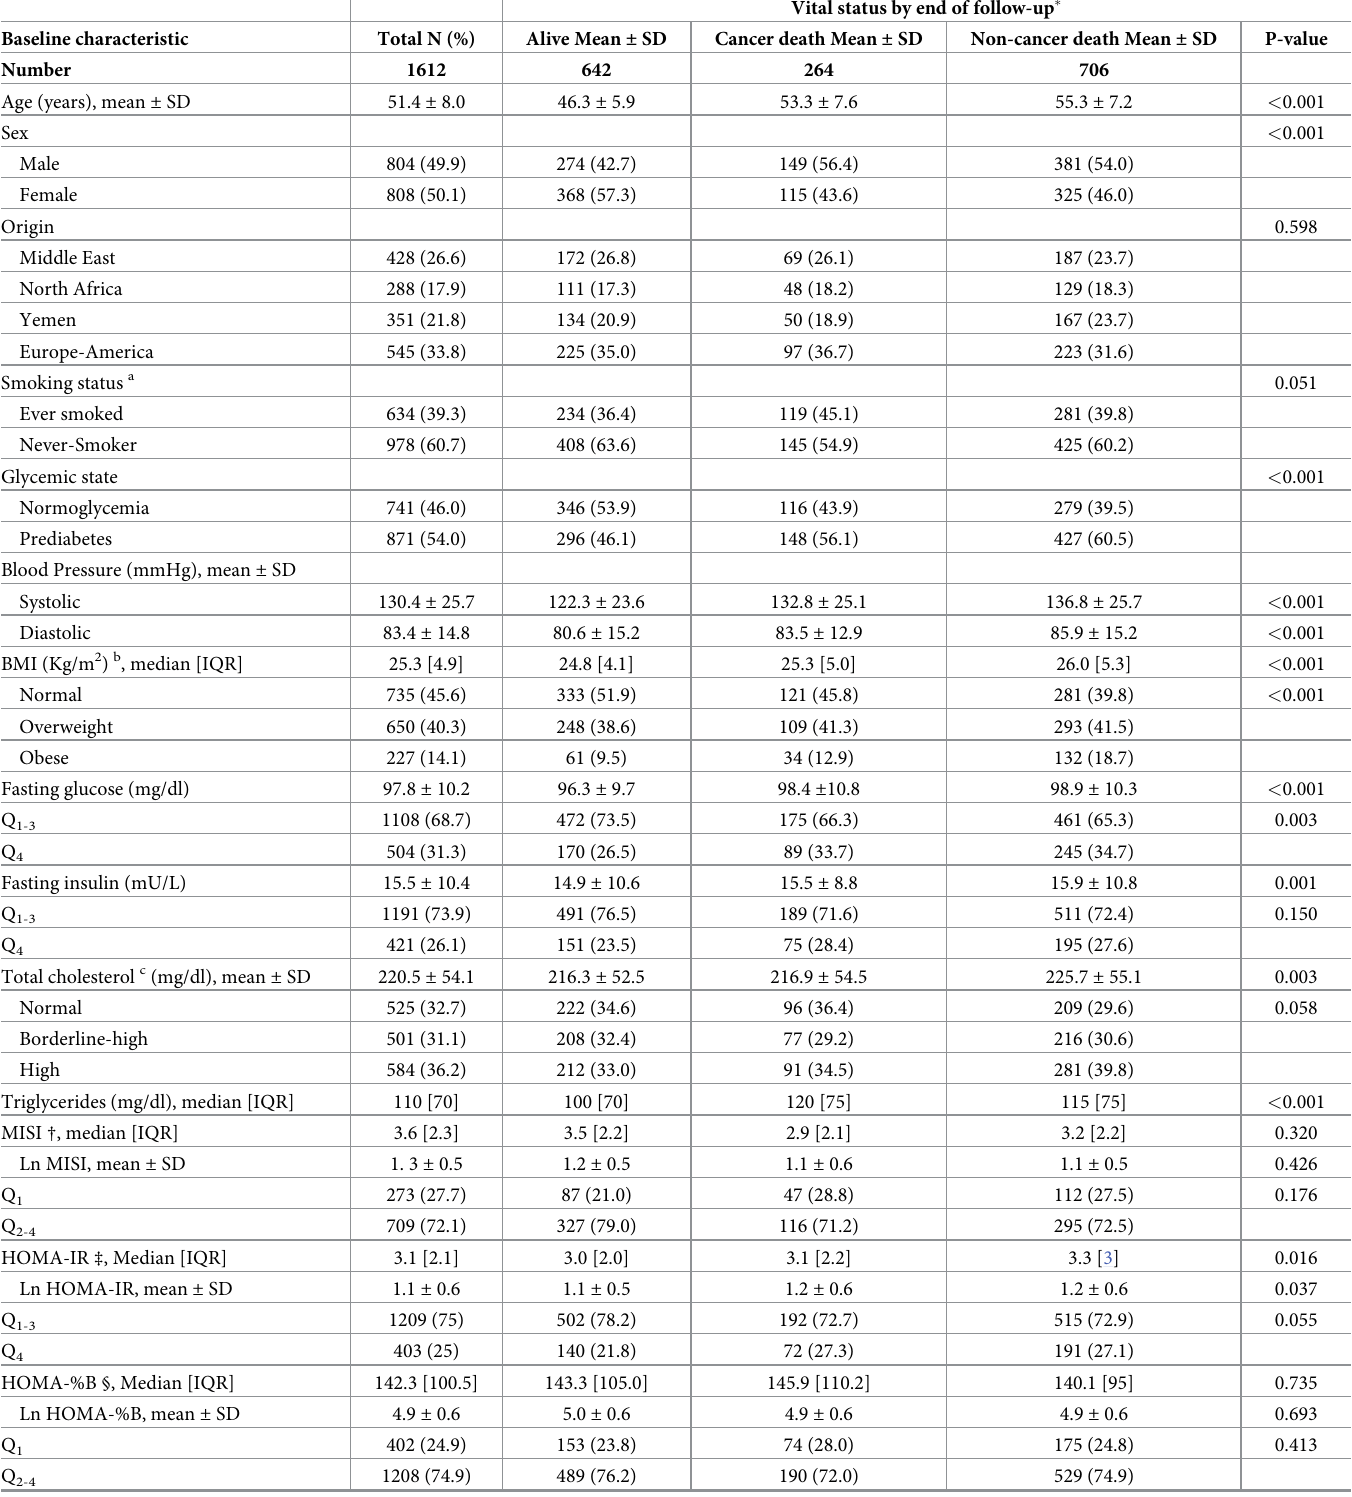
Vital status by end of follow-up